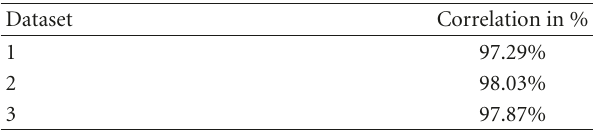
Table 1: Correlation between the real length of the artificial fibers and the automatic detection